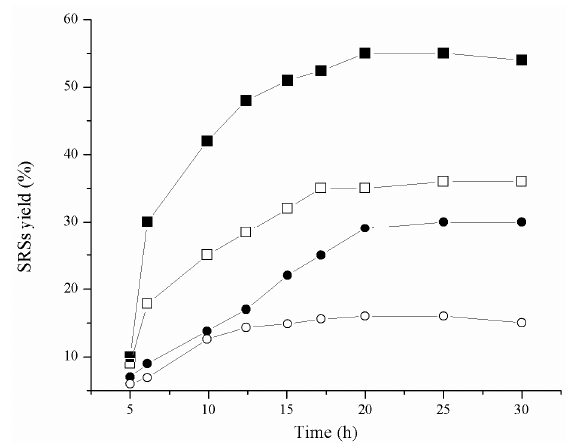
Figure 7. Changes in aqueous product yields (water soluble organic compounds: galactose, glucose, xylose and mannose) versus reaction time during cellulose hydrolysis. (- ○ -) MC, catalyst H 2 SO 4 ; (- ● -) MC, H 3 PW 12 O 40 catalyst; (- □ -) MC Pro-Phe, catalyst H 2 SO 4 ; (- ■ -) MC Pro-Phe, H 3 PW 12 O 40 catalyst.